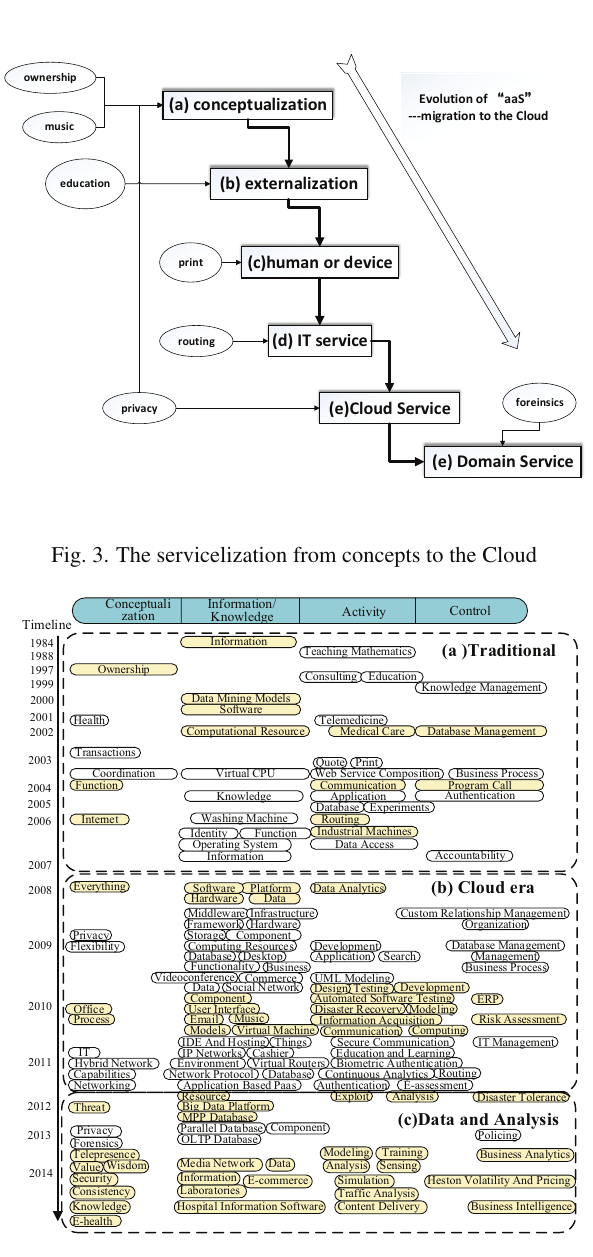
Fig. 4. Categorization on ”aaS” terms and its application on migration